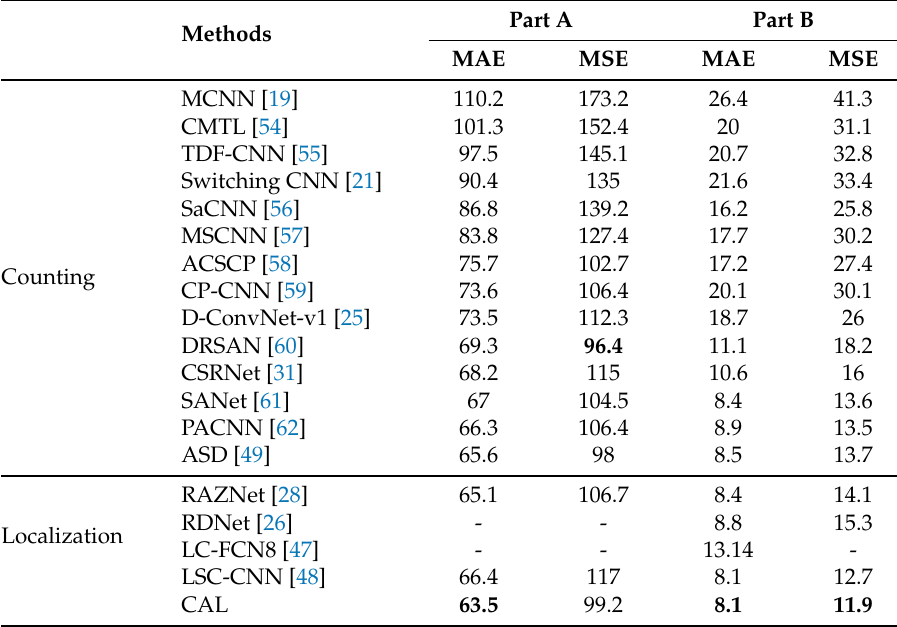
Table 3. The comparison among the state-of-the-arts and our approach in ShanghaiTech (Part A & Part B). The best result is in